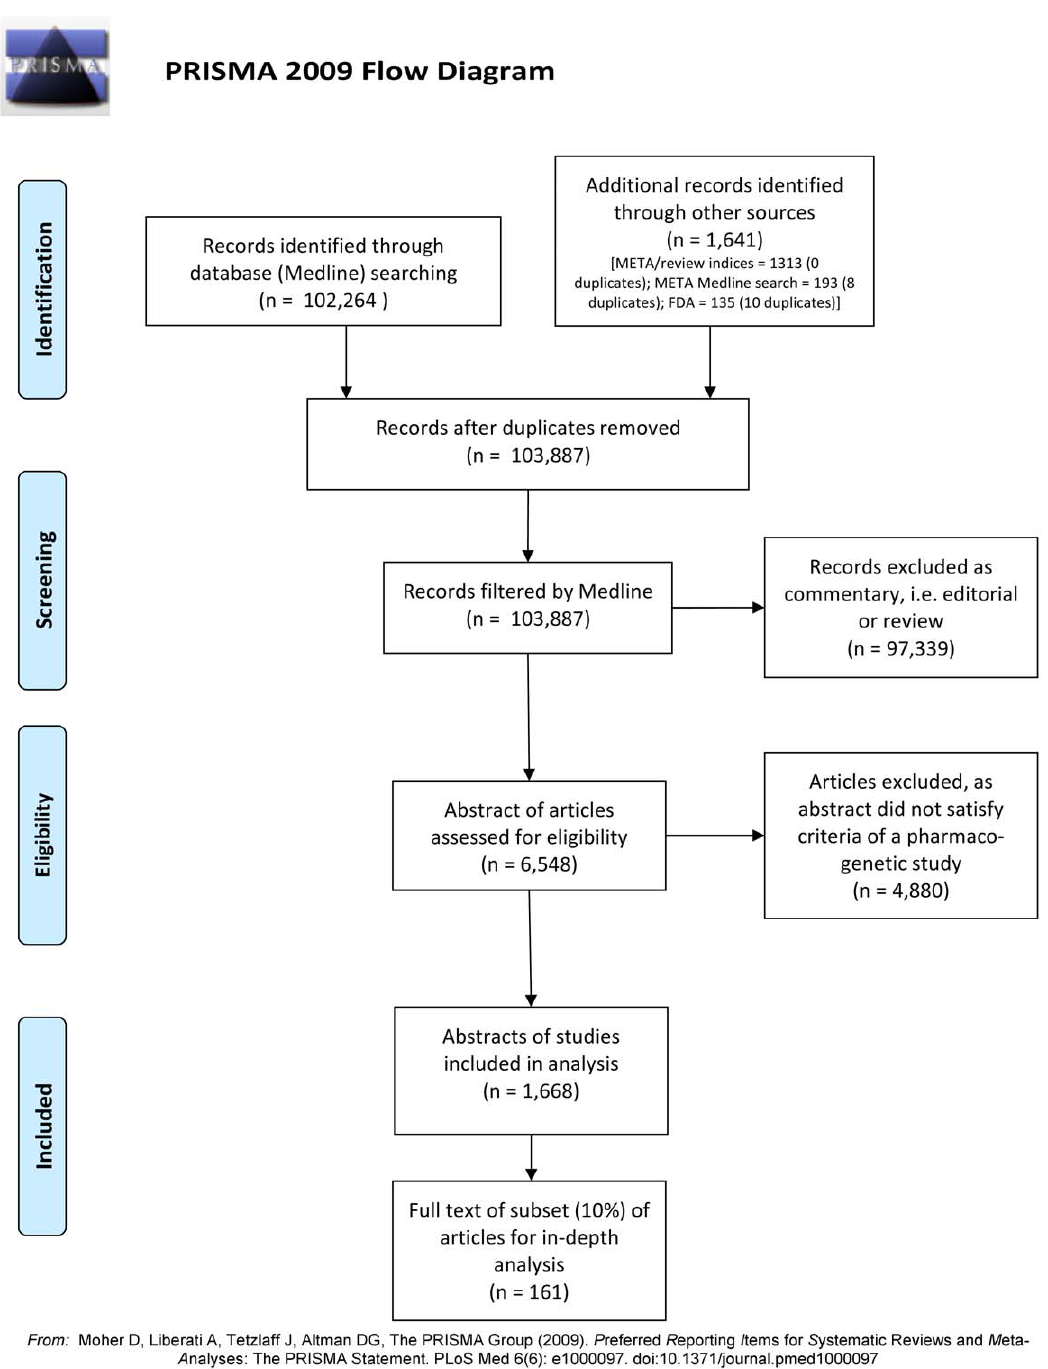
Figure 1. Flow chart of methodology for identifying pharmacogenetic studies in the systematic review. From PRISMA 2009 guidelines